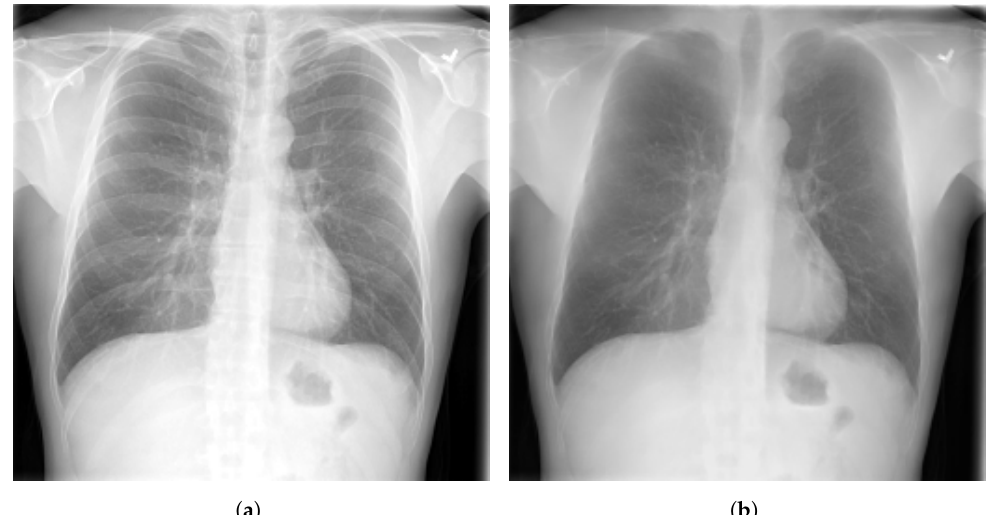
Figure 7. ( a ) CXR image from CheXpert dataset [44] before bone suppression; ( b ) CXR image after bone